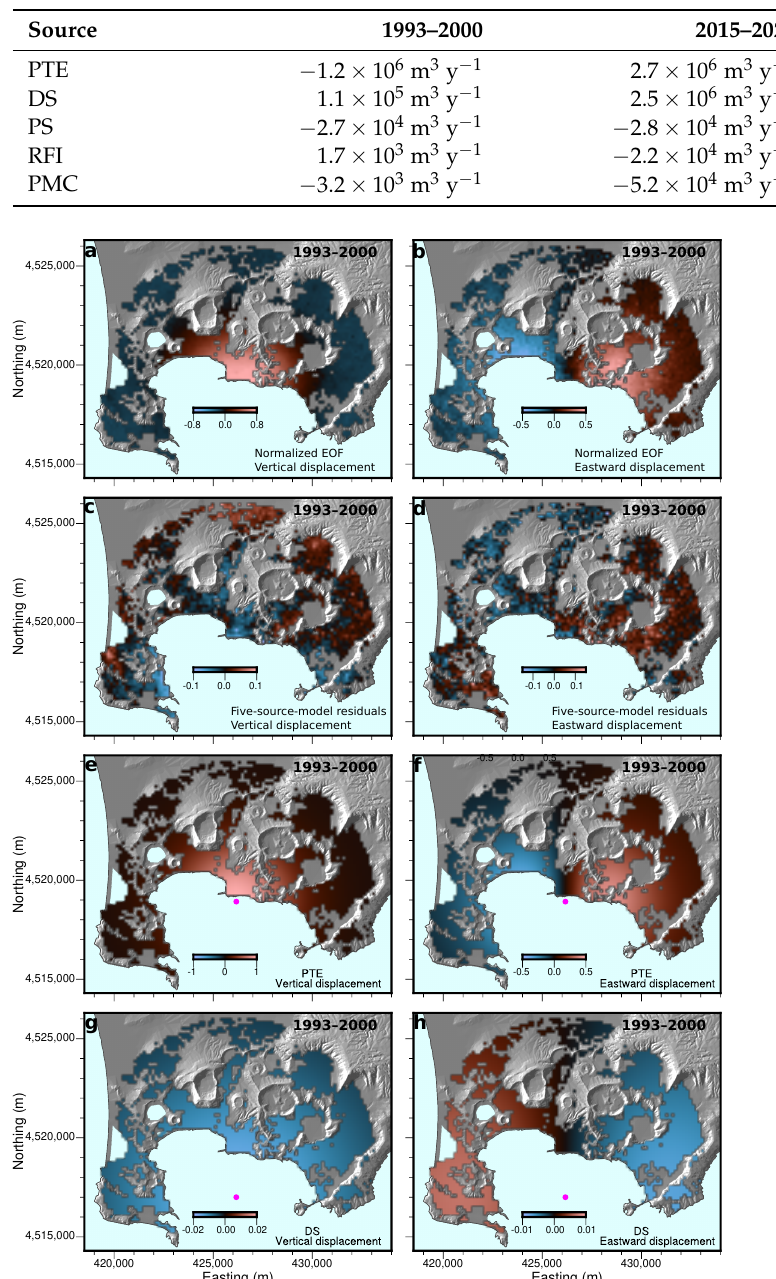
Figure 10. Modeling of the normalized 1993–2000 EOFs. ( a , b ) Normalized vertical and horizontal EOFs (˜ h v and ˜ h e in Equation (2), respectively), redrawn from Figure 7a,b. ( c , d ) Model residuals after 1 1 subtracting the cumulative contribution of the PTE, DS, PS, RFI and PMC. ( e , f ) Contribution of the (cid:0) (cid:1) (cid:0) (cid:1) a 1,1 / r v f v a 1,1 / r v f e PTE, i.e., and in Equation (2), respectively. ( g , h ) Contribution of the DS, 1 1 1 1 (cid:0) (cid:1) (cid:0) (cid:1) a 1,2 / r v f v a 1,2 / r v f e i.e., and in Equation (2), respectively. The magenta dot in panels ( e – h ) gives 2 2 1 1 the center position of the related